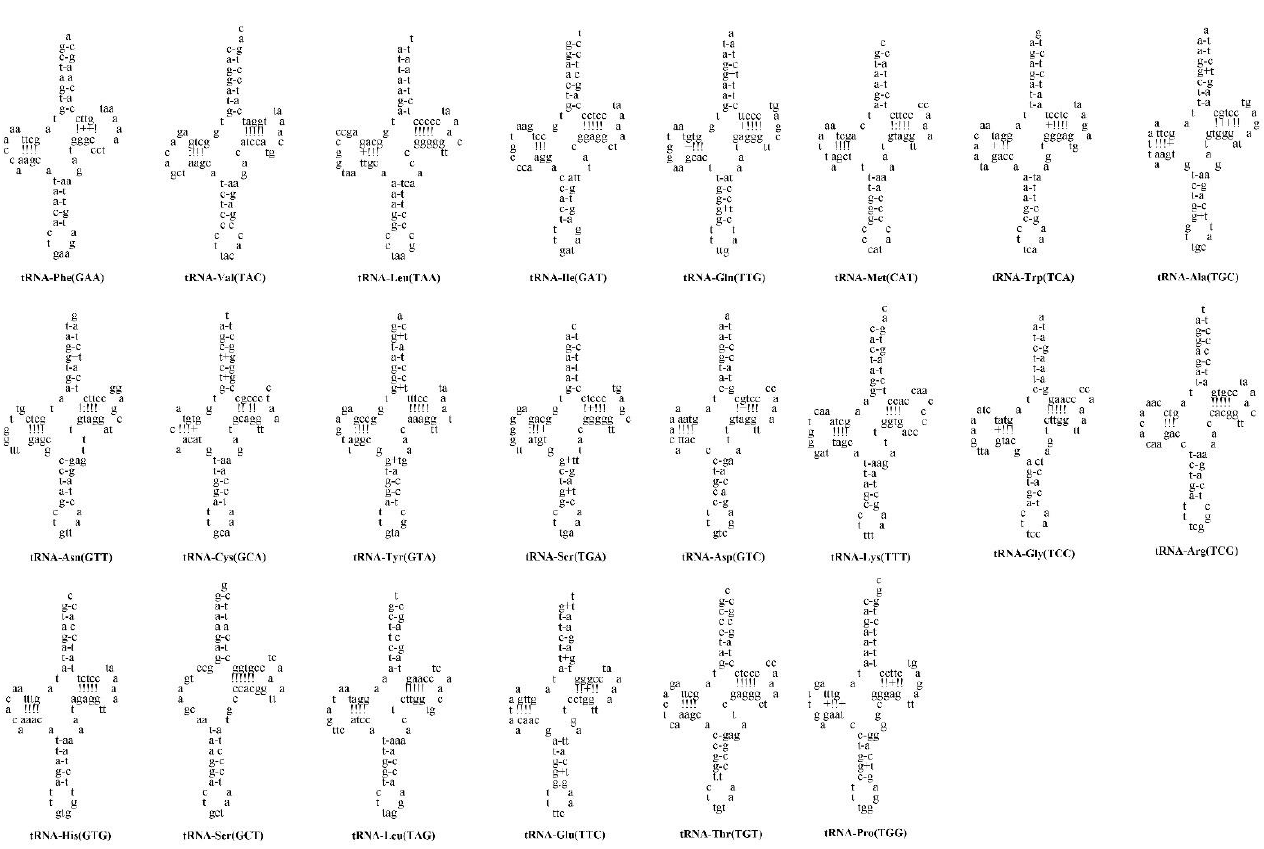
Figure 5. Putative secondary structures for 22 tRNA genes in mtDNA of A. maculatus . Watson–Crick and GT bonds are expounded by “‑” and “+”, respectively.